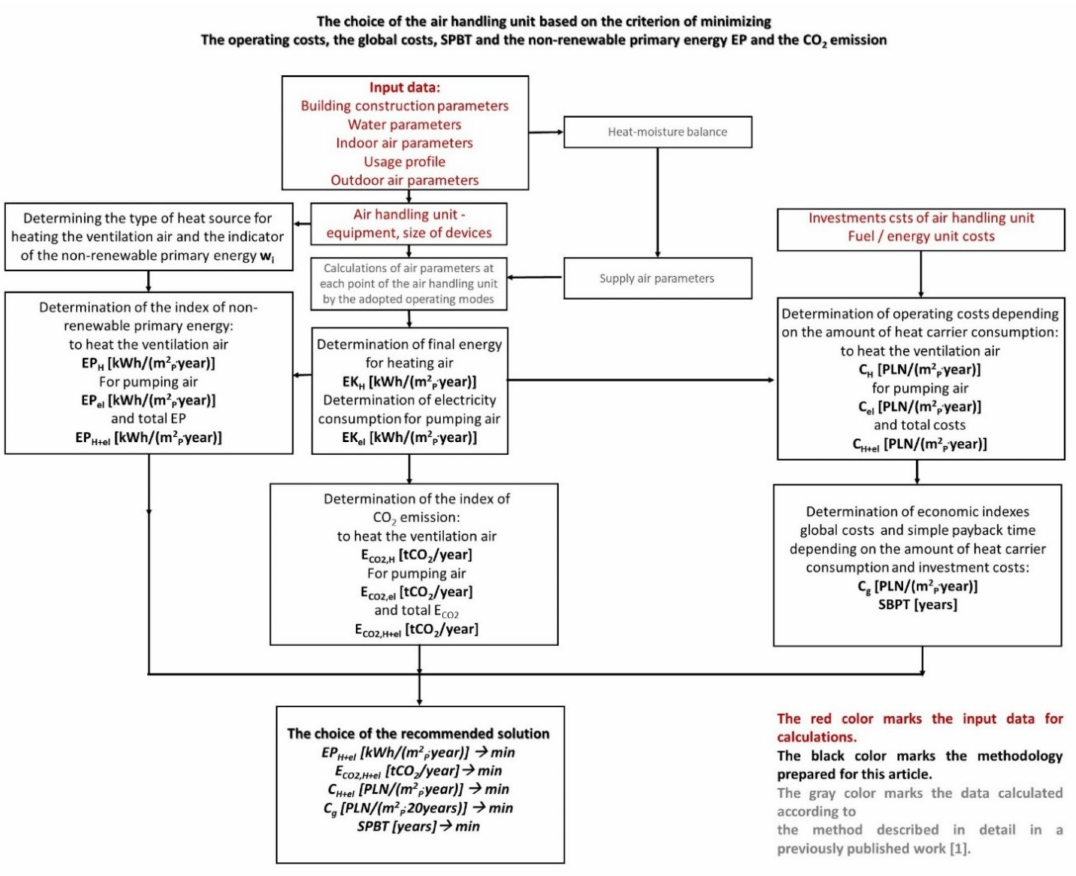
Figure 3. Selection of the ventilation unit based on the minimization of the operating costs, the global costs, simple payback time (SPBT), and the primary energy index and CO 2